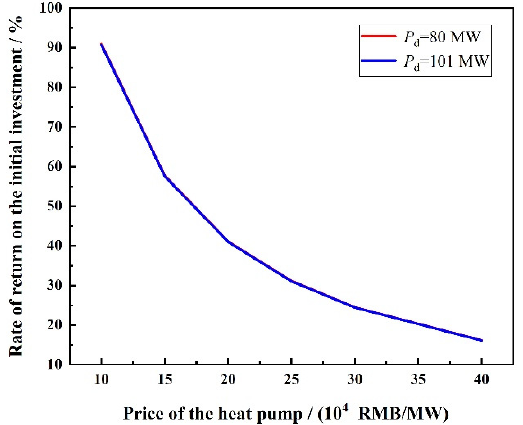
Figure 10. Annual after-tax profits vs. uthe nit price of the recovery system using an absorption heat pump.